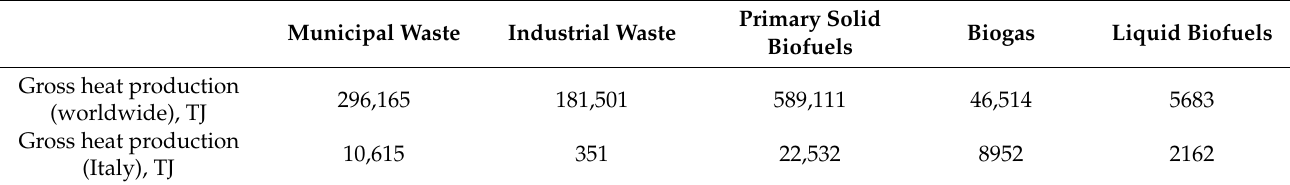
Figure 1. Electricity generation from biofuels and waste by source worldwide ( a ) and Italy ( b ). Table 2. Gross heat production by waste source (2018) [6]. Based on IEA data from IEA (2020) Renewable electricity capacity additions, 2007–2021, updated IEA forecast, IEA (2020), www.iea.org/statistics, All rights